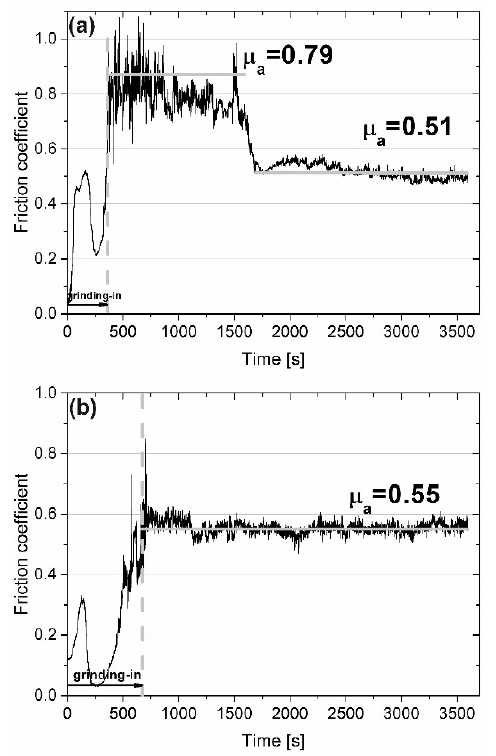
Figure 6. Results of wear test conducted at 400 °C for sintered Ni-50%NiCr(80/20) ( a ) and Ni-